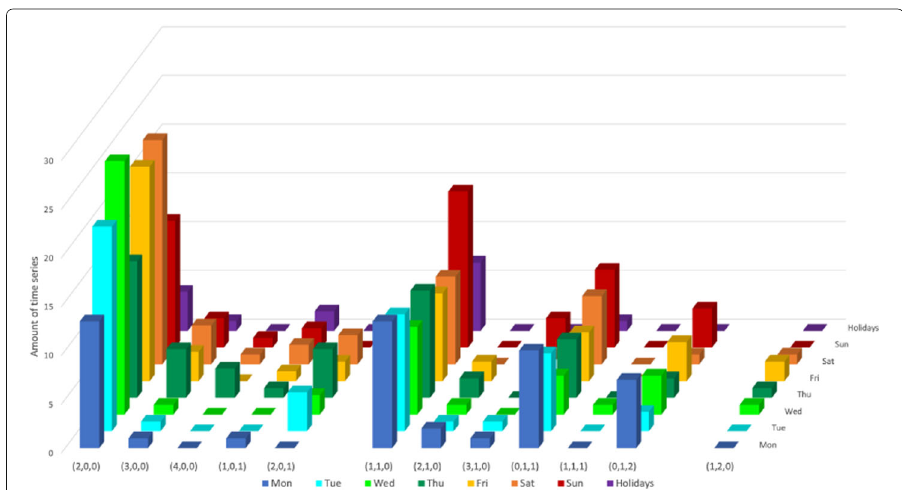
Fig. 6 Amount of time series per cluster (AIC) per weekday